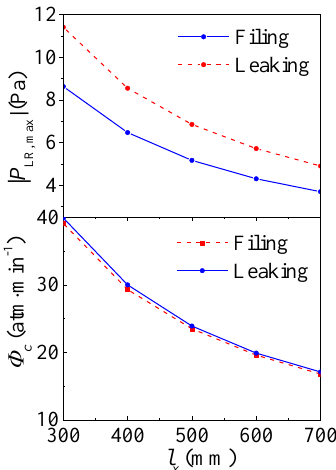
Figure 11. Effects of the diameter of the microcapillary fill tube l x on the critical pressure variation rate Φ c and the maximum pressure difference across the hole on the support tent Δ P LR, max . ( d o = 0.2 mm, N s = 1, d x = 0.1 mm).